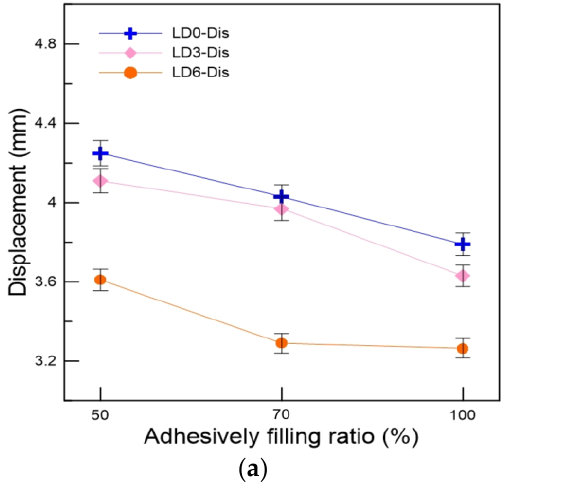
Figure 11. Variation in the maximum ( a ) displacement and ( b ) tensile load of the tensile test specimens according to the adhesive filling ratio.